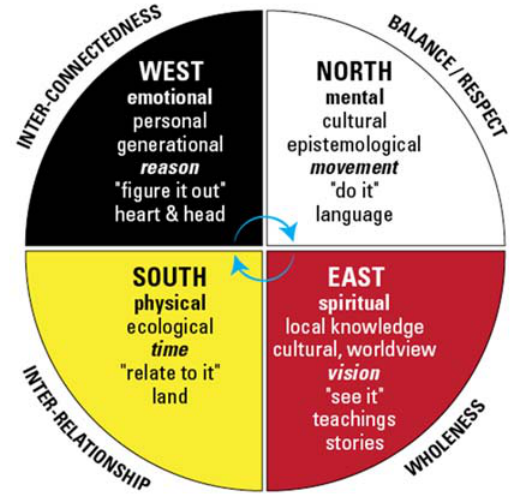
Figure 1. Medicine Wheel (Bell 2013). This figure depicts an Anishinaabe Medicine Wheel and the corresponding teachings that align with the various sections of the wheel.